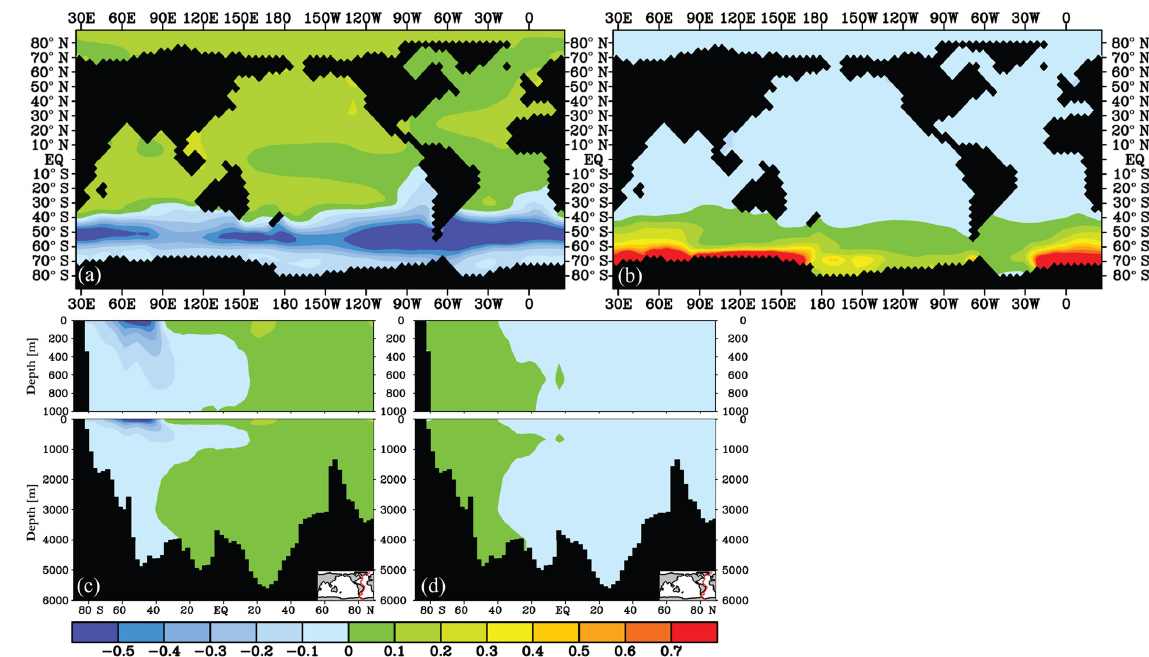
Figure 9. δ 13 C of DIC (‰) difference after 2000 years for the Antarctic sea ice cover experiments (experiment − control): the effect of a large (a, c) and small (b, d) Antarctic sea ice cover, for 25m depth (a, b) and an Atlantic transect (c, d)